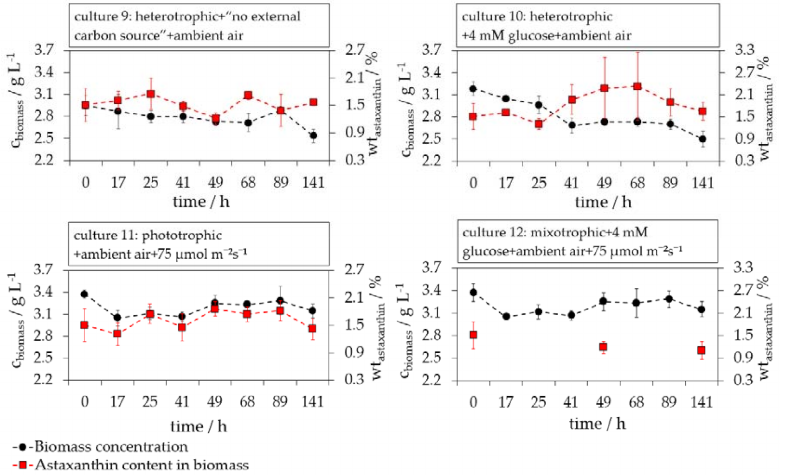
Figure 9. Time course of the biomass concentration and the astaxanthin content in the algal biomass of heterotrophic culture 9 (heterotrophic + “no external carbon source” + ambient air) and culture 10 (heterotrophic + 4 mM glucose + ambient air), phototrophic culture 11 (phototrophic + ambient air + 75 µ mol m − 2 s − 1 ) and mixotrophic culture 12 (mixotrophic + 4 mM glucose + ambient air + 75 µ mol m − 2 s − 1 ). Biomass concentration: error bars show ± SD, n = 3. Astaxanthin content: error bars show ± SD, n = 3 at t = 0 h, t = 49 h and t = 141 h and ± SD, n = 2 at t = 17 h, t = 25 h, t = 41 h, t = 68 h and t = 89 h of one biological sample; asterisks indicate significant differences ( t -test) of measured value vs. control (t = 0 h) at p <